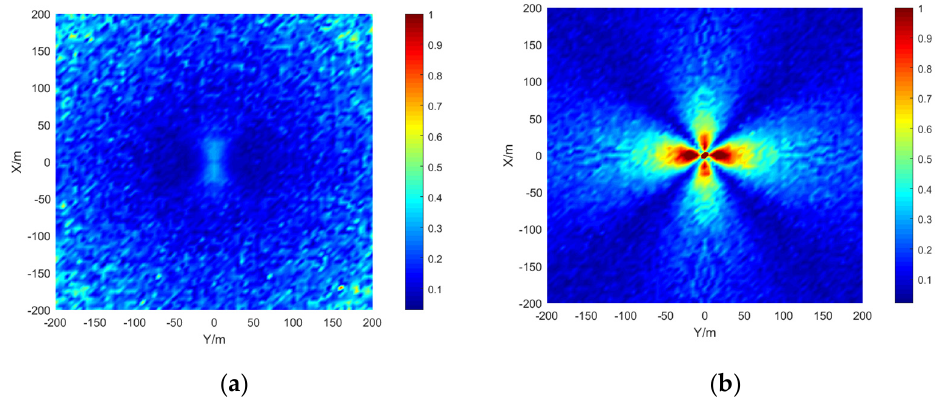
Figure 9. Positioning accuracy of stereo array 1. ( a )parallel wave algorithm ( b )vector projection algorithm.